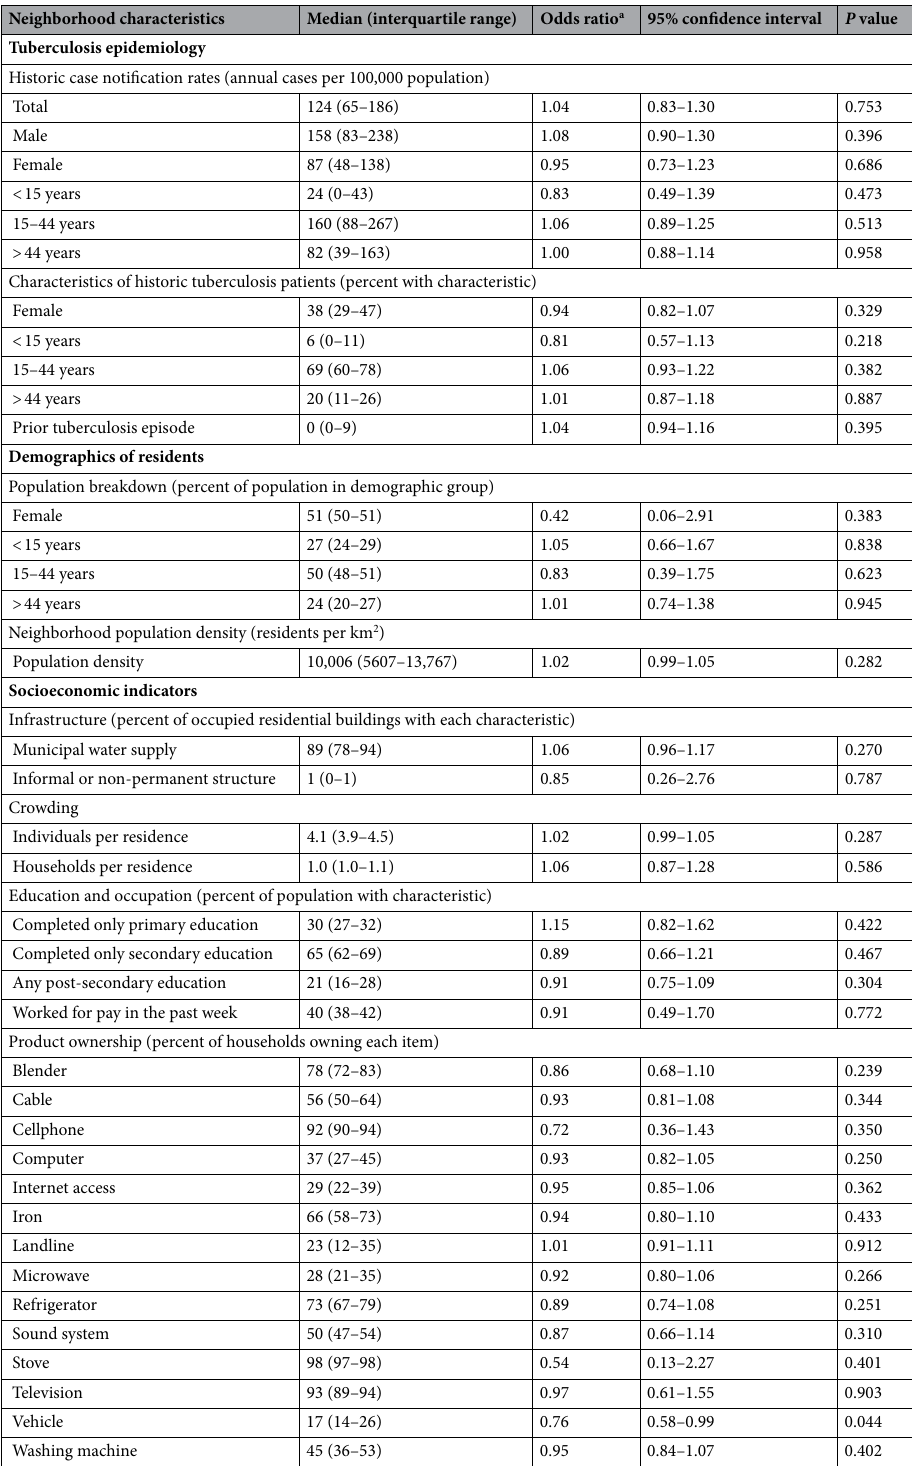
Table 2. Associations between neighborhood characteristics and tuberculosis screening yield based on logistic regression ( n = 73 neighborhoods). a Odds ratios for population density is represented for the change in 1000 people per km 2 ; odds ratios for historic case notification rates are represented for the change in 100 cases per 100,000 population; all other odds ratios are represented per 10% unit increase in the predictor